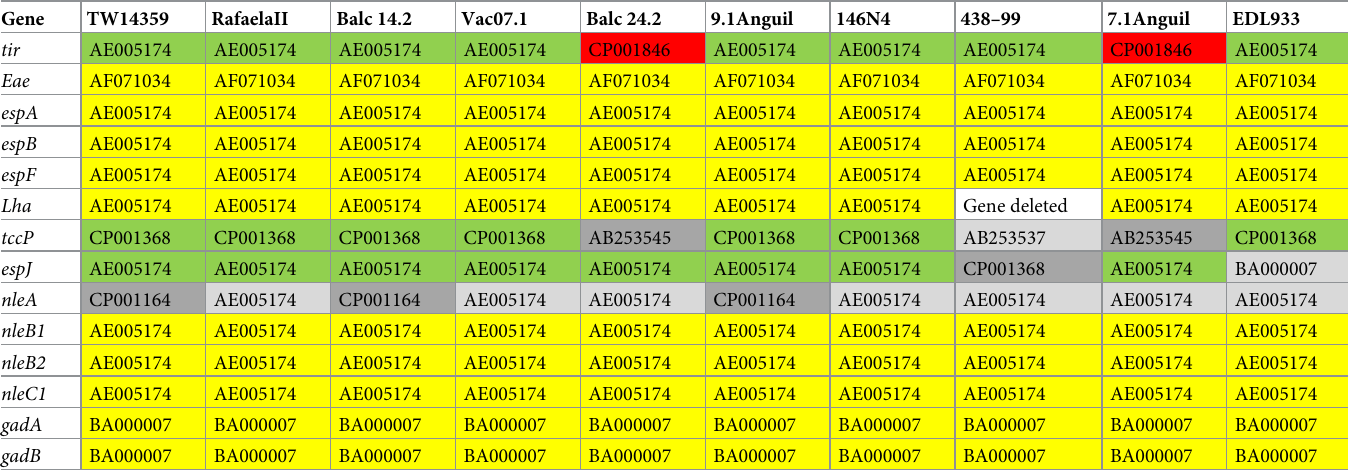
Table 4. According to Virulence Finder alleles are named for its accession number a